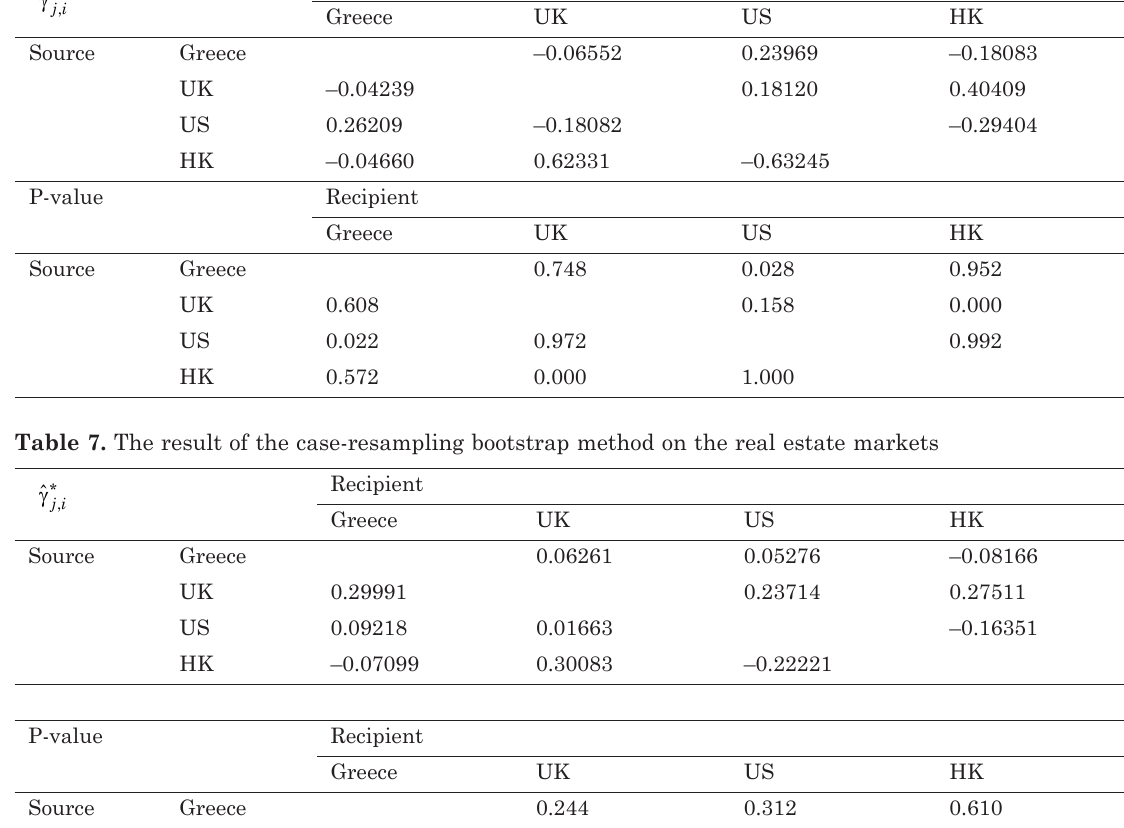
Table 6. The result of the case-resampling bootstrap method on the equity markets * γ ˆ , j i